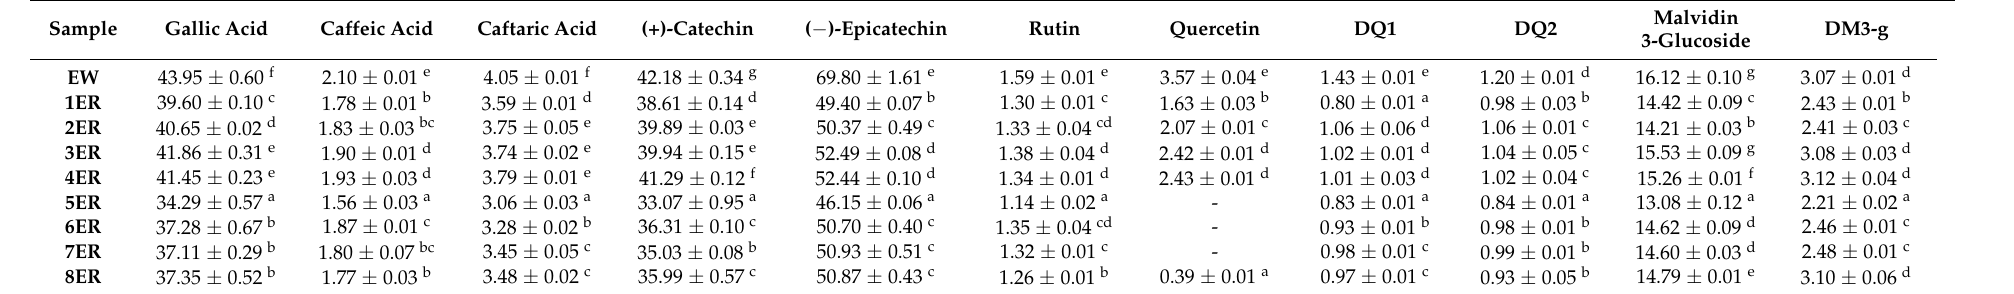
Table 6. Concentration (mg/L) of individual phenolic compounds in the initial ecological Cabernet Sauvignon red wine and retentates obtained by reverse osmosis at 2.5, 3.5, 4.5, and 5.5 MPa with cooling and without